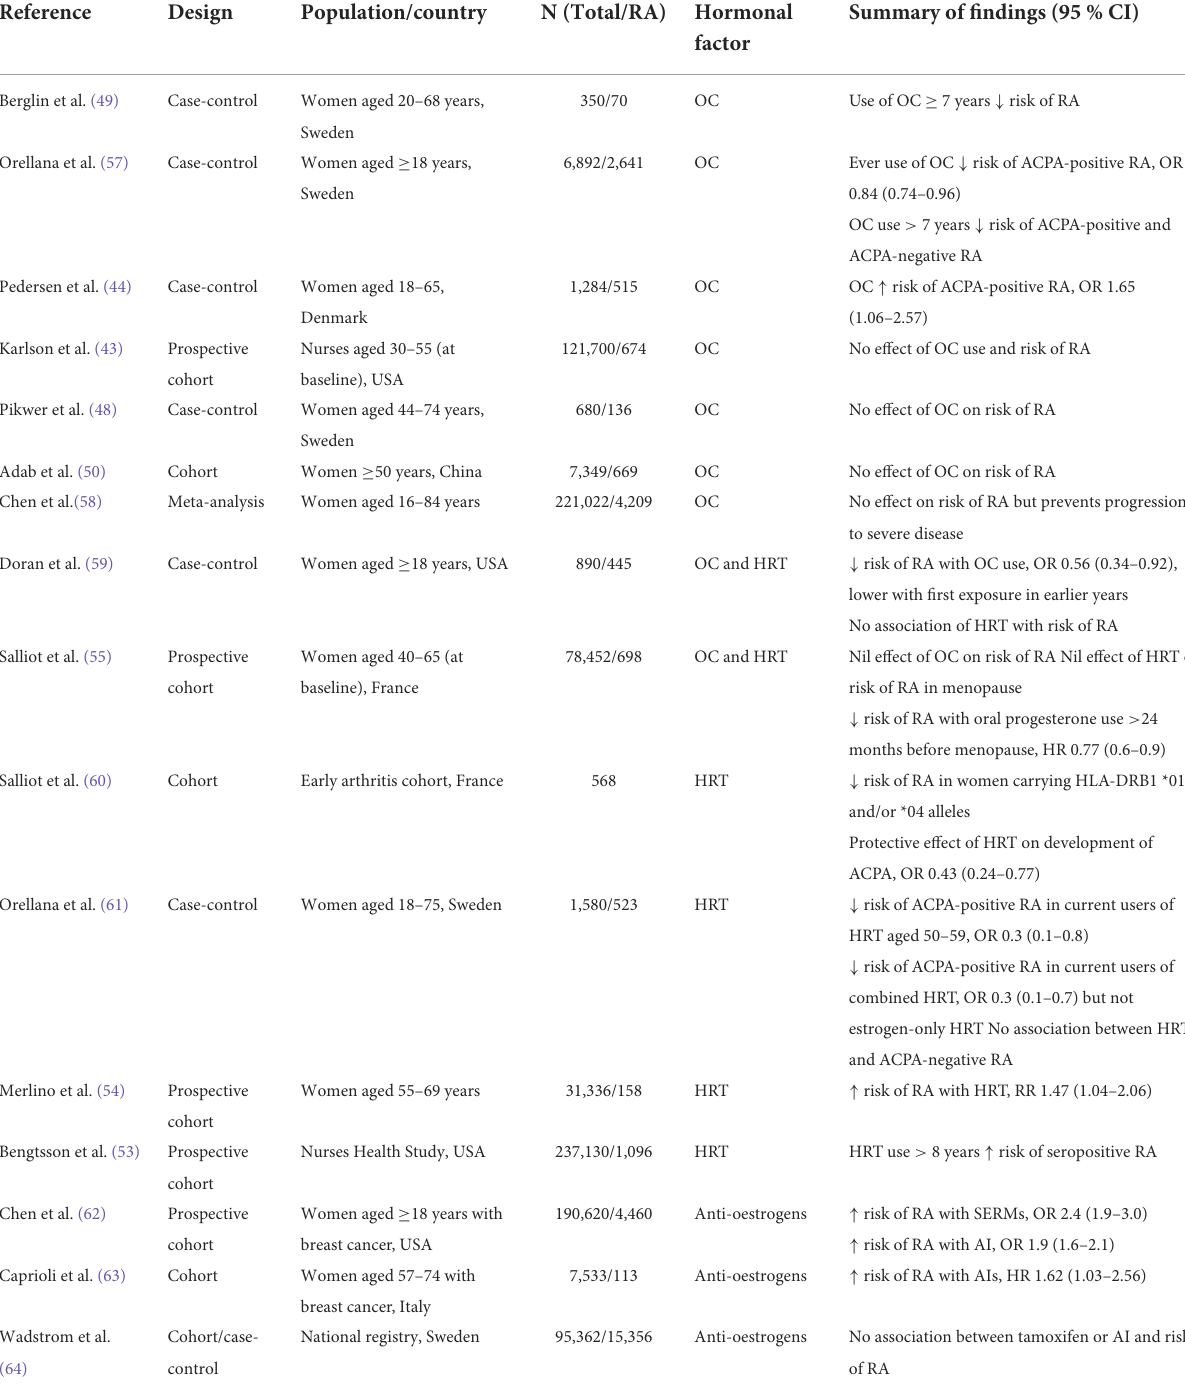
TABLE 3 Epidemiological studies of exogenous sex hormones and RA